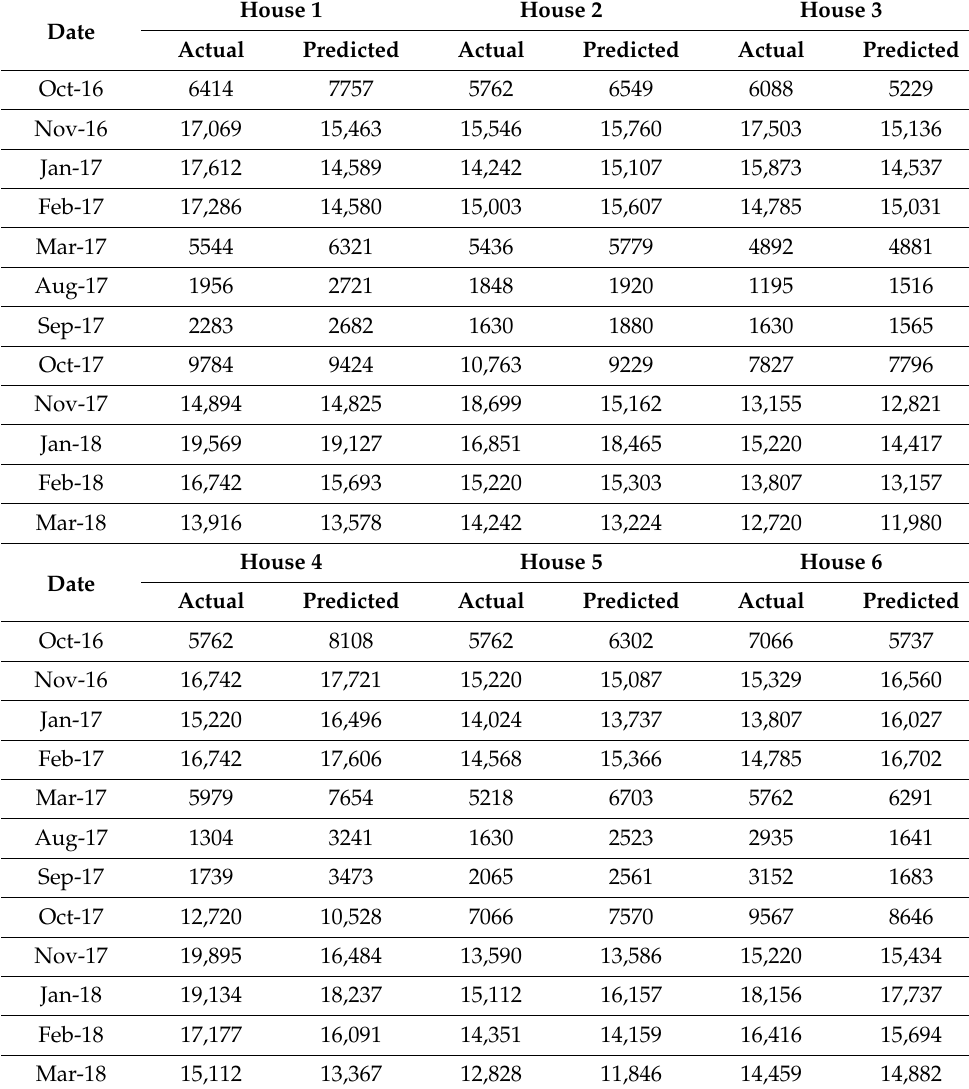
Table A1. Actual and predicted data for 12 months of the testing houses using the best